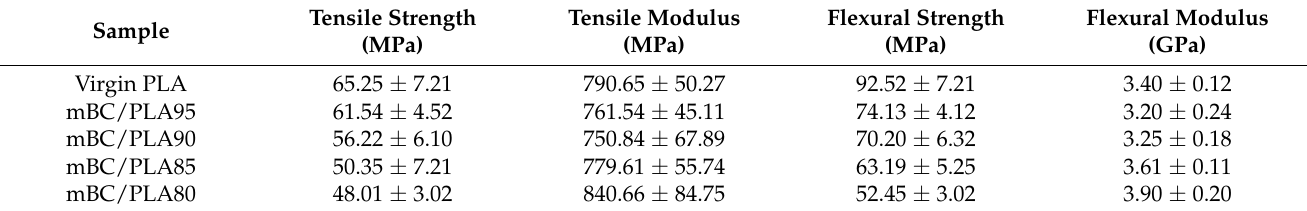
Figure 5. Tensile ( a ) and flexural ( b ) properties of PLA composites (error bars represent standard deviation). Table 2. Mechanical properties of PLA composites ± stdev.